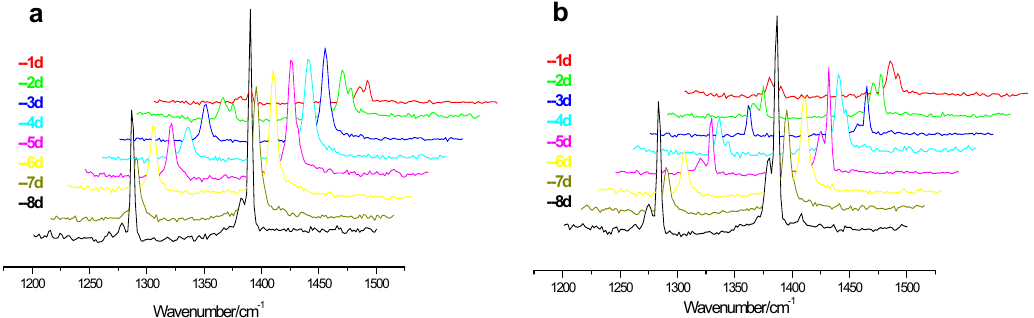
Figure 4. The Raman spectroscopy change of CO 2 hydrate at point “B” for experiment 1 ( a ) and experiment 2 ( b ), where the 1d, 2d, 8d represent the first, the second, the eighth day of the experiment process.